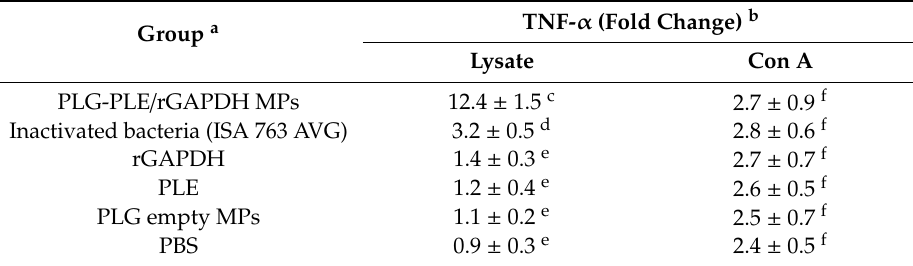
Table 2. TNF- α production of head kidney lymphocyte cultures from vaccinated grouper. Group